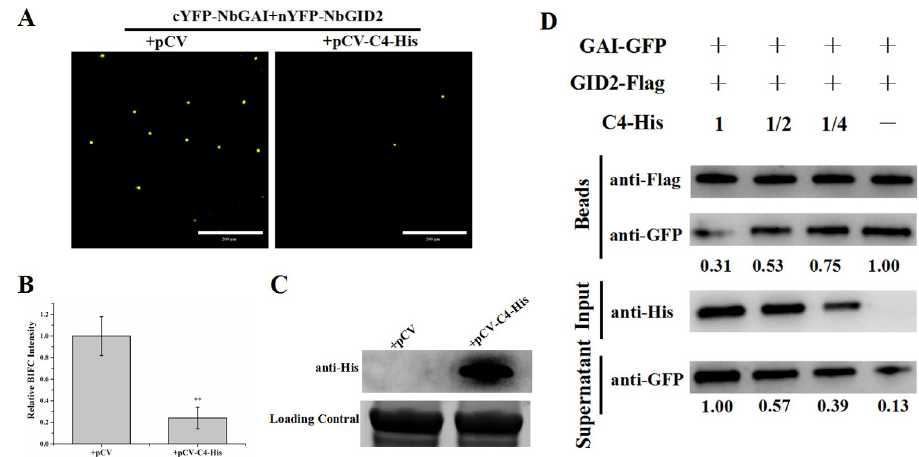
Fig 5. ALCScV C4 can inhibit the interaction between NbGAI and NbGID2. (A) Results of the competitive BiFC assay show the inhibitory effect of ALCScV C4 on the interaction between NbGAI and NbGID2. Fusion cYFP-NbGID2, nYFP-NbGAI and C4-His or cYFP-NbGID2, nYFP-NbGAI and empty vector were co-expressed in N . benthamiana leaves through agroinfiltration. The infiltrated leaves were harvested at 48 hpi and examined under a confocal microscope. Scale bar = 200 μ m. (B) Results of statistical analyses showing the number of nuclei with YFP fluorescence per examined area. �� indicates a significant difference between the two treatments at the P < 0.01 level with Student’s t -test. These experiments were performed with three independent biological replicates with similar results. (C) Results of the Western blot analysis showing the expression level of ALCScV C4. After electrophoresis, the blot was probed with an anti-His antibody. Coomassie brilliant blue (CBB)-stained RuBisCo large subunit gel to confirm equivalent sample loadings. (D) Results of the competitive pull-down assay show the interaction between NbGAI-GFP and NbGID2-Flag in vitro . In this assay, purified NbGAI-GFP (4 μ g) was mixed with 0, 2, 4, or 8 μ g purified C4-His, respectively, and then incubated with 4 μ g immobilized NbGID2-Flag.